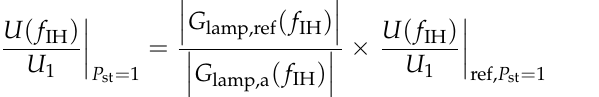
(15), the interharmonic ratio of different frequencies corresponding to this lamp for P st = 1 could be calculated, and the interharmonic-flicker limit curve could be